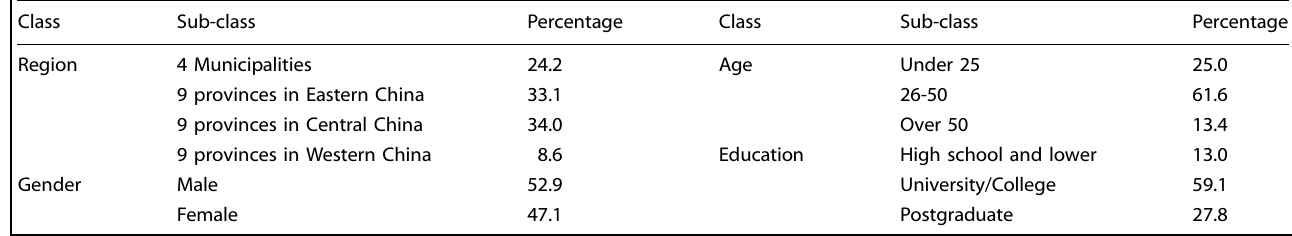
Table 1. Demographic characteristics of the surveys.